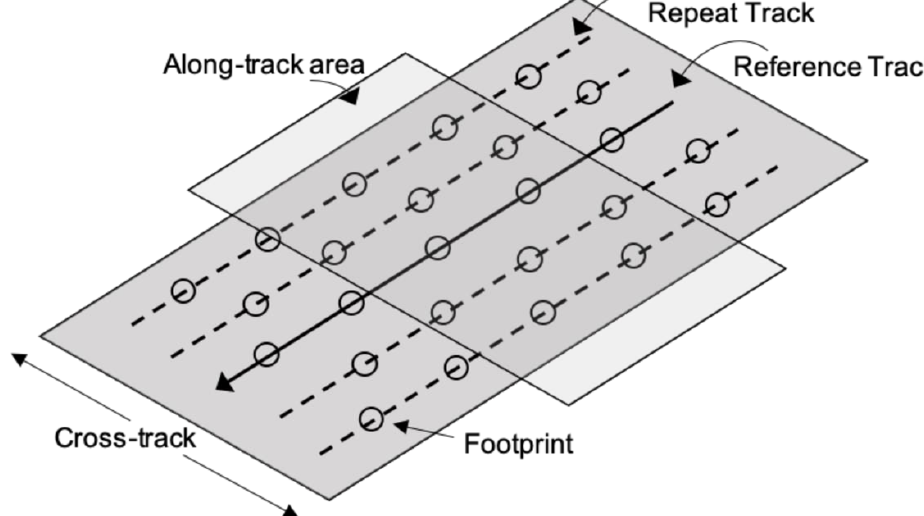
Figure 3. Illustration of altimeter (e.g., ICESat) reference track and repeat tracks. Repeat tracks are parallel to reference tracks but separated in the cross-track direction. An area of interest in the along-track direction is used to collect ground footprint measurements that are spatially interpolated to recover the area-average surface elevation and subsequent change in area-average surface elevation dH / dt . In practice, repeat tracks are often not parallel owing to orbital variations, and in the case of ICESat laser altimetry, footprint diameter may change owing to laser transmit power variation.